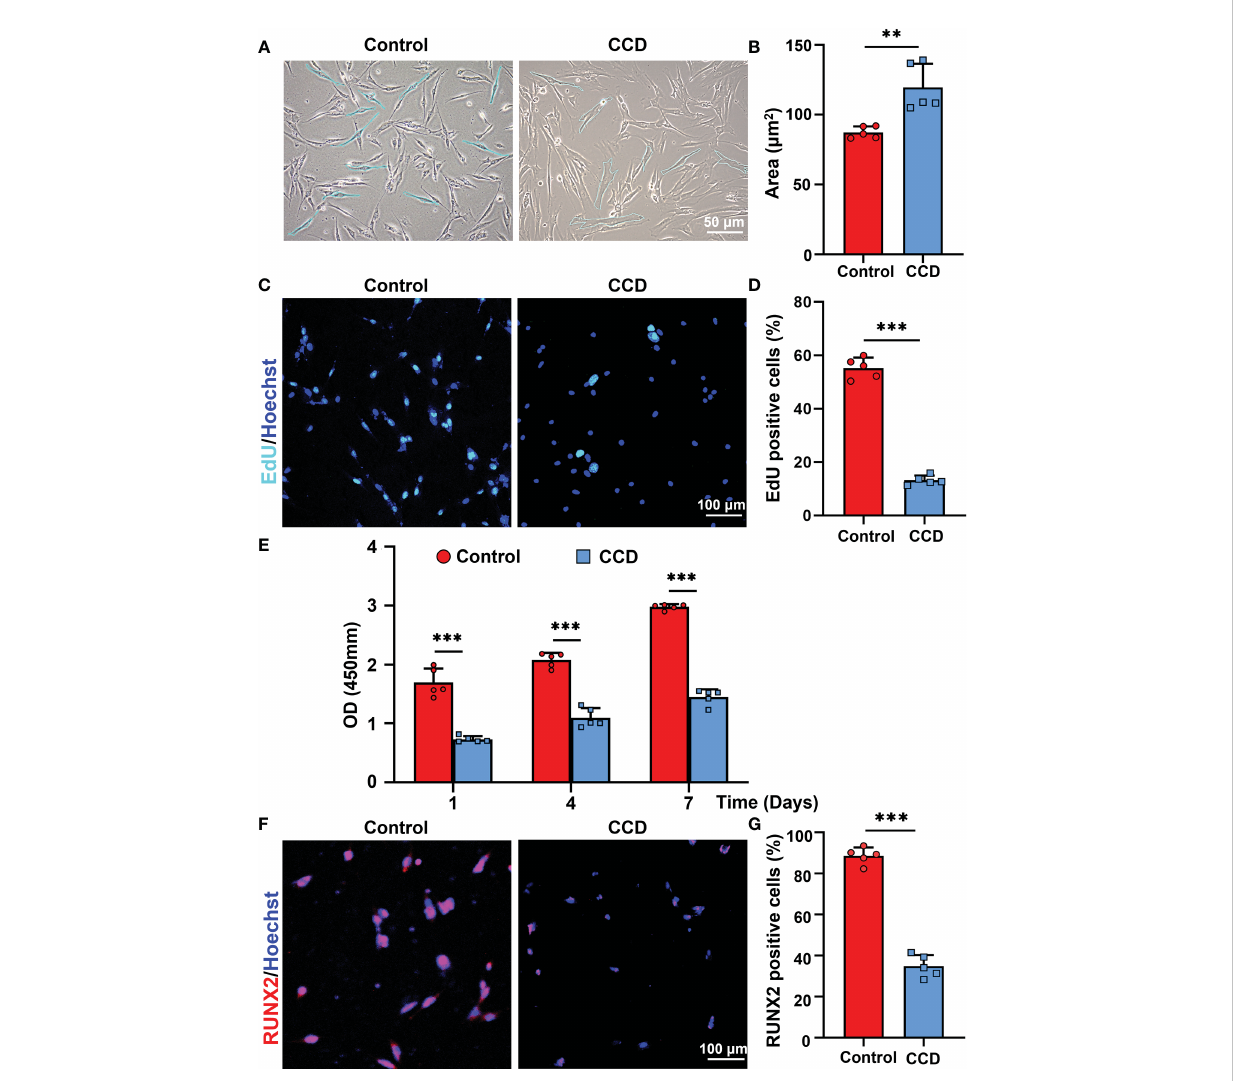
FIGURE 5 The SHED from CCD exhibits impaired proliferative property. (A) Optical microscopy showing the morphology and size of the fourth-generation cells. Scale bar: 50 m m. (B) The bar graph illustrates the areas of cells (n = 5, **p < 0.01). (C) CLSM showing the results of cell proliferation of SHED. Scale bar: 100 m m (n = 5, *** P < 0.001). (D) The bar graph illustrates the proportion of EdU positive cells (n = 5, ***p < 0.001). (E) Cell viability of SHED cultured after 1, 4 and 7 d (n = 5, ***p < 0.001). (F) RUNX2 expression on the SHED from the two groups. Scale bar: 100 m m. (G) The bar graph illustrates the percentage of RUNX2 positive cells (n = 5, ***p <